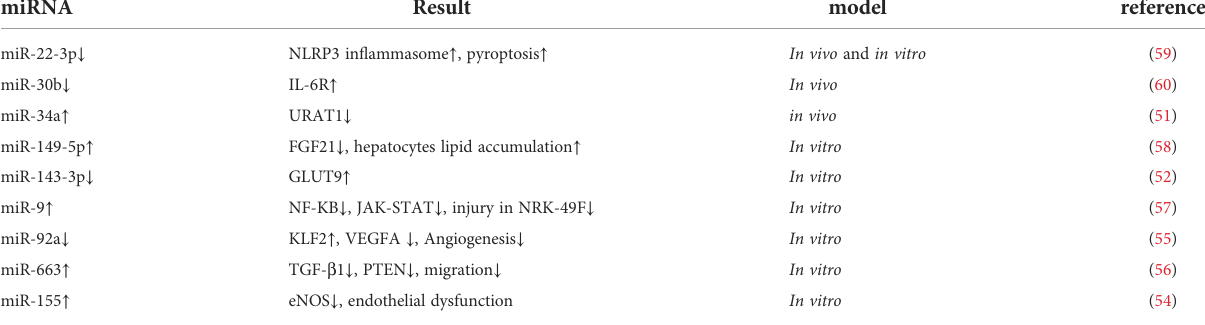
TABLE 1 The miRNAs involved in Hyperuricemia.